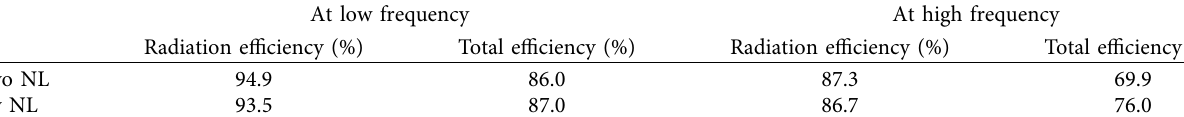
Table 1: Comparison of the radiation efficiency and total efficiency of antenna#2 w/wo NL. At low frequency